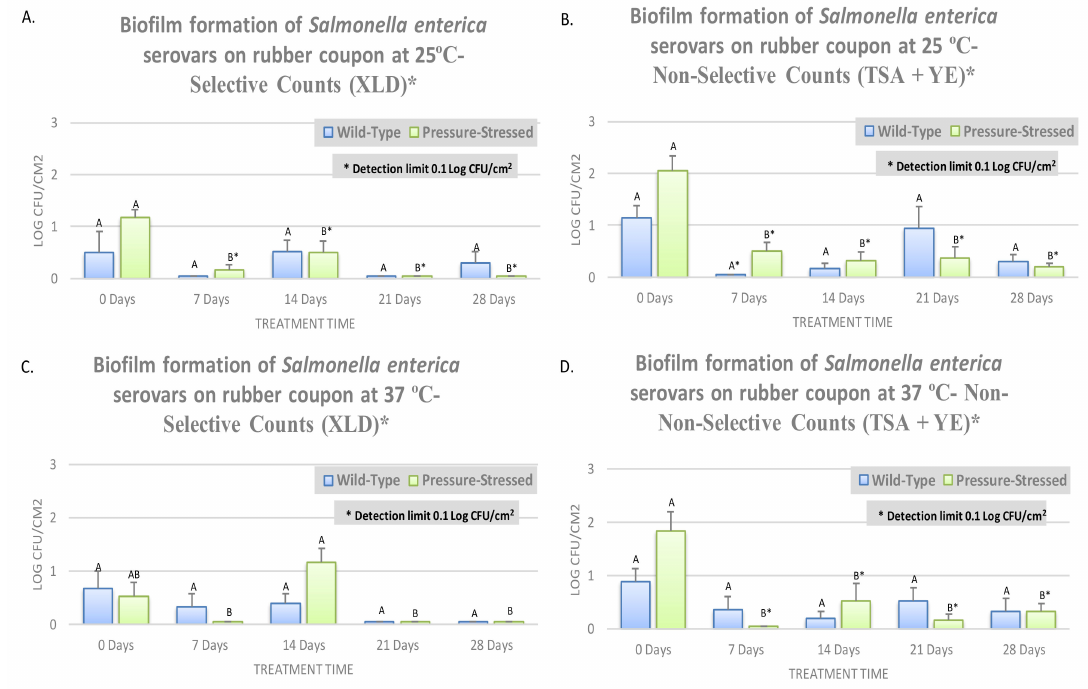
Figure 3. Survival and biofilm formation of a five-strain cocktail of Salmonella serovars (ATCC ® numbers 13076, 8387, 6962, 9270, 14028), wild-type, and treated by elevated hydrostatic pressure (pressure-stressed) at 15,000 PSI (Barocycler Hub880, Pressure BioScience Inc., South Easton, MA, USA) for 15 min on rubber coupons in autoclaved Cumberland river water for 0, 7, 14, 21, and 28 days at 25 and 37 ◦ C. In each graph, each column of each time interval followed by di ff erent uppercase letters are representing log CFU / cm 2 values that are statistically ( p < 0.05) di ff erent (Tukey-adjusted ANOVA). Uppercase letters followed by * sign are statistically ( p < 0.05) di ff erent than the untreated control (Dunnett’s-adjusted ANOVA). The detection limit on both selective (XLD) and non-selective (TSA + YE) media was 0.1 log CFU / cm 2 . ( A ) Survival of biofilm cells on XLD at 25 ◦ C; ( B ) Survival of biofilm cells on TSA + YE at 25 ◦ C; ( C ) Survival of biofilm cells on XLD at 37 °C; ( D ) Survival of biofilm cells on TSA + YE at 37 ◦